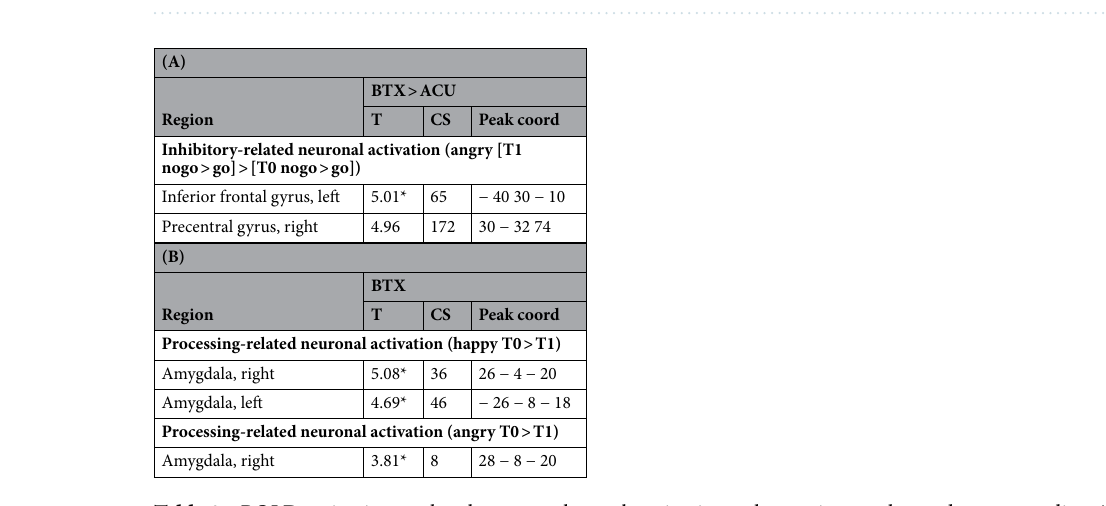
Figure 1. Behavioral effects of BTX and ACU in the emotional go-/no-go task and brain activation of the GO/ NO-GO × TIME × GROUP interaction for angry pictures: ( A ) Shown are the pre- and post-scores of sensitivity [d ′ ], separately for angry and happy pictures. ( B ) BOLD activations (FWE corrected on a cluster level) of the primary motor cortex (no-go > go) over time (T1 > T0) in the BTX group compared to the ACU group. For visualization results are overlaid on a T1-weighted image.